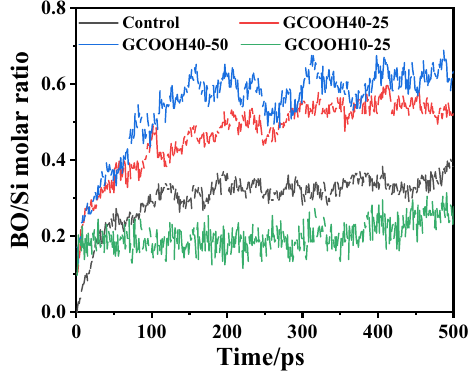
Figure 3: Variation curves of Bo/Si for the di ff erent systems.